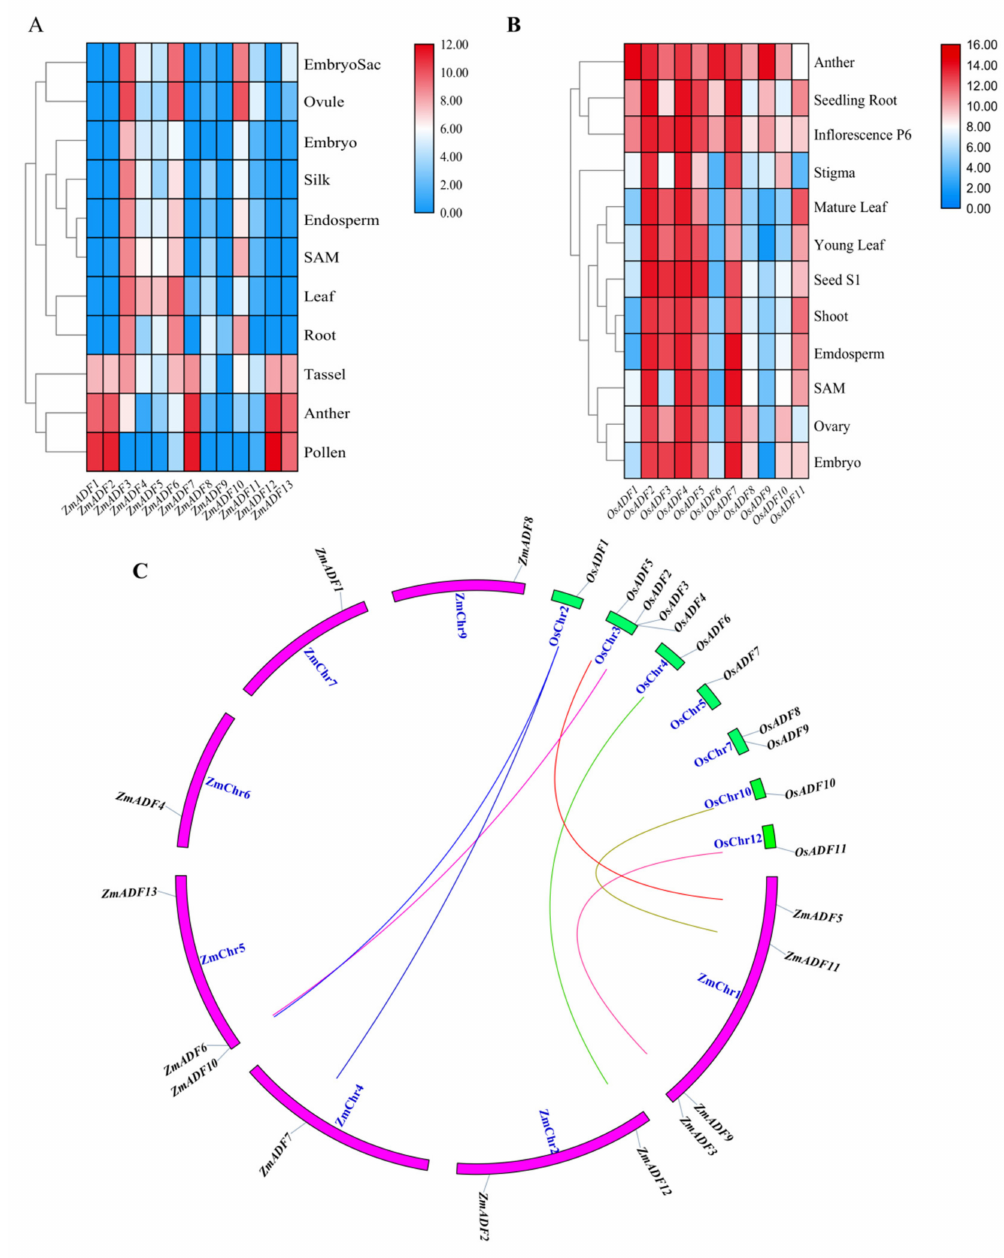
Figure 5. Expression profiles of ADF genes in maize and rice. ( A ) The expression of ADF gene family members in di ff erent tissues of maize; ( B ) Expression of OsADFs in di ff erent rice tissues; ( C ) Orthologous gene pairs between maize and rice. The letters SAM indicates stem apical